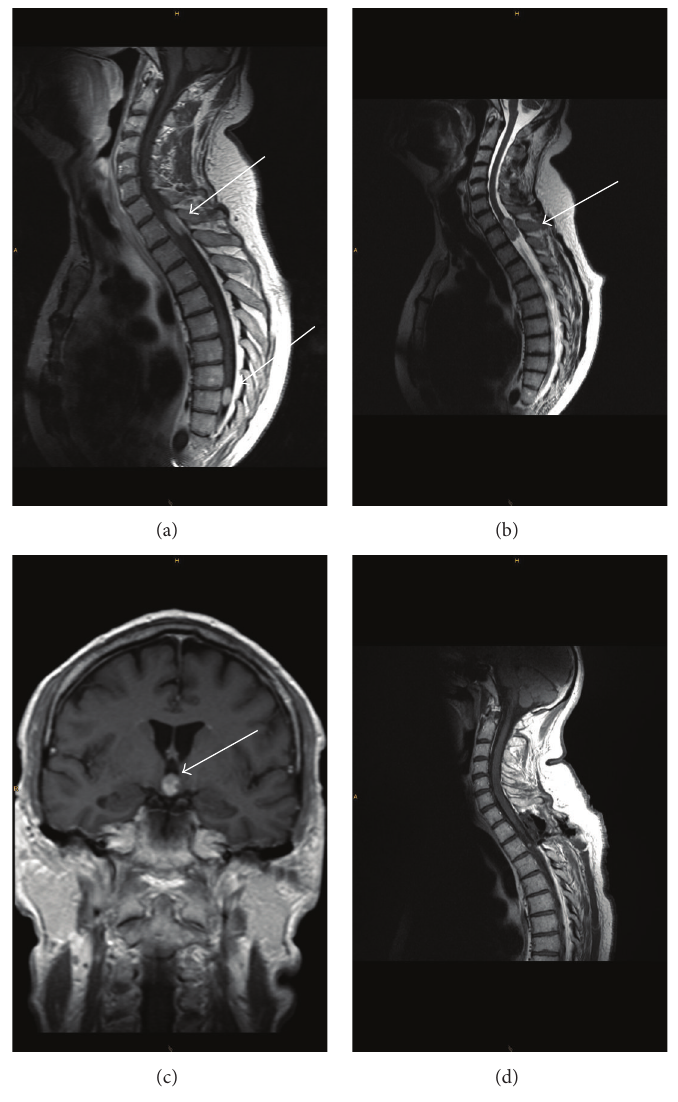
Figure 1: (a) A sagittal postgadolinium T1-weigthed image shows the two lesions before surgery. (b) The tumor at level C7-T1 in T2-weigthed image. (c) In cranial T1-weighted image, the small tumor is located on the floor of the third ventricle. (d) T1-weighted image shows the postoperative